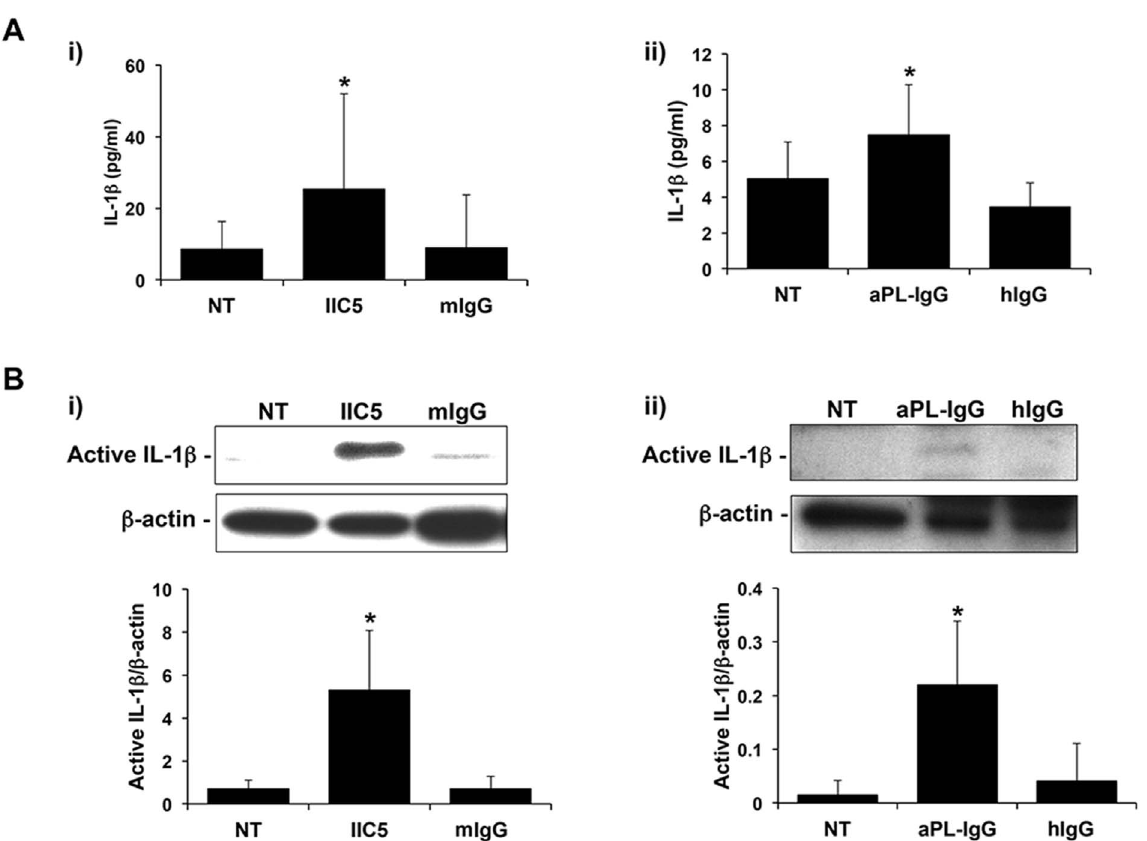
Figure 1. Antiphospholipid antibodies induce trophoblast IL-1 b processing and secretion. Trophoblast cells were either not treated (NT) or treated with (i) the anti- b 2 GPI mAb, IIC5 (20 m g/ml) or mouse IgG1 control (mIgG; 20 m g/ml); or (ii) human aPL-IgG (500 m g/ml) or normal human IgG control (hIgG; 500 m g/ml) for 72 hrs. (A) Barcharts show levels of secreted IL-1 b as determined by ELISA. Data are from 5 independent experiments. * p , 0.01 versus the NT control. (B) Trophoblast cells were evaluated for active IL-1 b (17 kDa) expression by Western blot (representative blots are shown). Barcharts below show quantification of protein expression as determined by densitometry and normalized to b -actin. Data are from 3 independent experiments. * p , 0.05 versus the NT